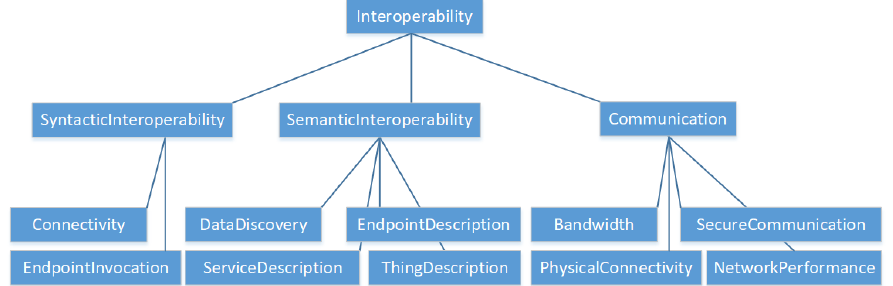
Figure 3. Interoperability-related concerns. Lower level concerns influence the fulfillment degree of higher ones.